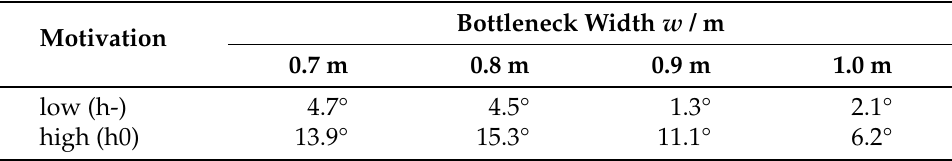
Table 2. Maximum rotation angle of the pelvis while passing through the bottleneck (0.2m before and after the wall forming the